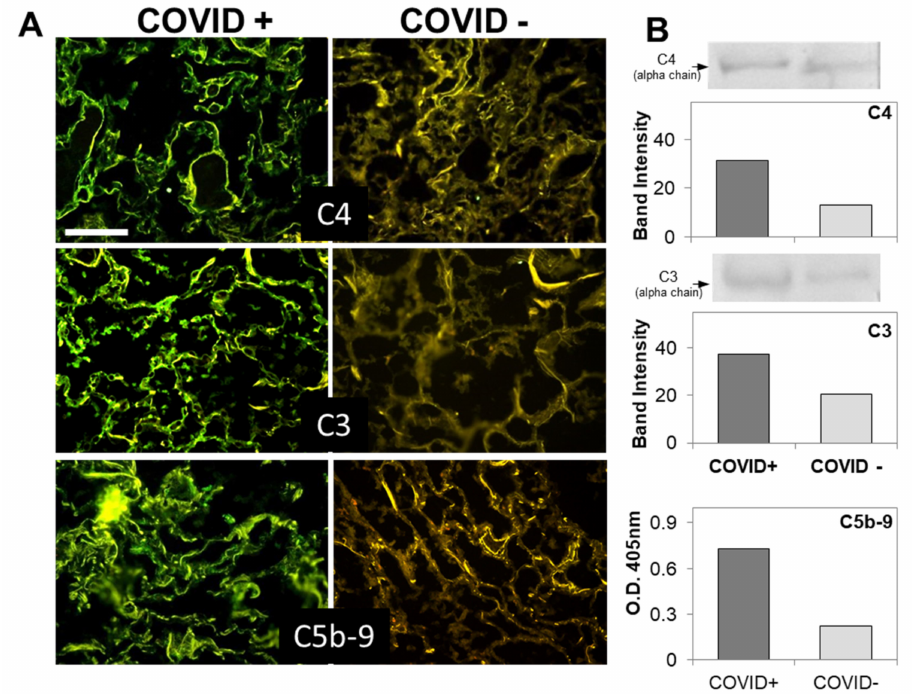
Figure 2. ( A ) Detection of complement components in lung sections by immunofluorescence analysis. The panel shows representative immunofluorescence images obtained from the analysis of several sections of lung autopsy samples from 12 SARS-CoV-2-positive and 3 negative cases. The sections were stained to reveal the presence of C4, C3, and C5b-9, as explained in materials and methods, and examined by three independent observers. Scale bar = 50 µ m. ( B ) Evaluation of complement components by western blot in the lungs of a COVID+ and a COVID − patients. The columns represent the staining intensity of the western blot bands quantified using ImageJ (Fuji-NIH). Western blot bands of C4 and C3 are shown on top of the corresponding columns. C5b-9 levels were measured by ELISA and expressed as OD readings at 405